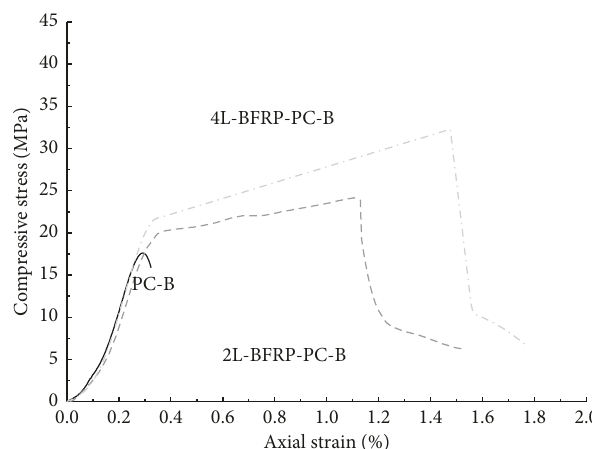
Figure 6: Effect of BFRP layers on the axial stress-strain behavior of the 160 ∗ 320mm BFRP-PC.